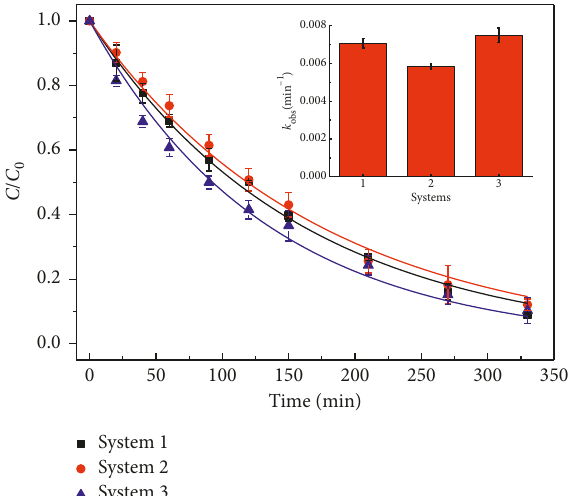
Figure 7: Effects of different cations on AMO degradation by TAP. Solid lines represent the pseudo-first-order kinetic model fits. Insert: changes of k obs at different pH values. Experimental con- ditions: [AMO] 0 � 0.1mM; [PS] 0 � 10mM; T � 50 ° C; reaction time � 330min.